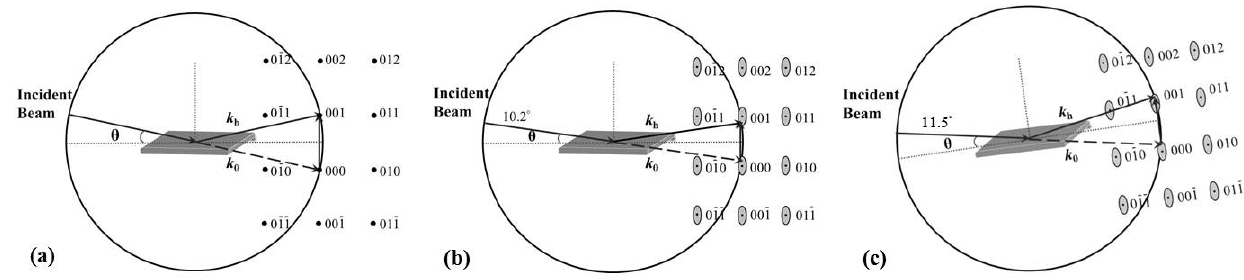
Figure 4. Ewald’s sphere construction for ( a ) uniform (001) single crystal; and a non-uniform (001) single crystal with an incident beam angle of ( b ) 10.2°; and ( c ) 11.5°.